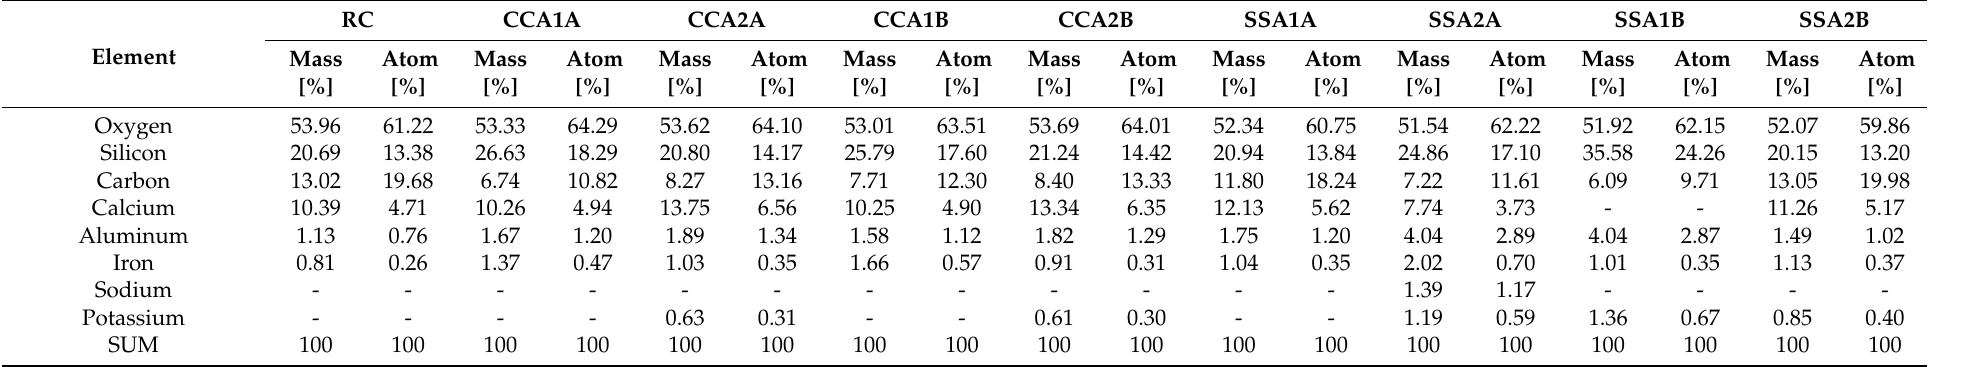
Table 4. Chemical composition of the studied concretes, according to EDS